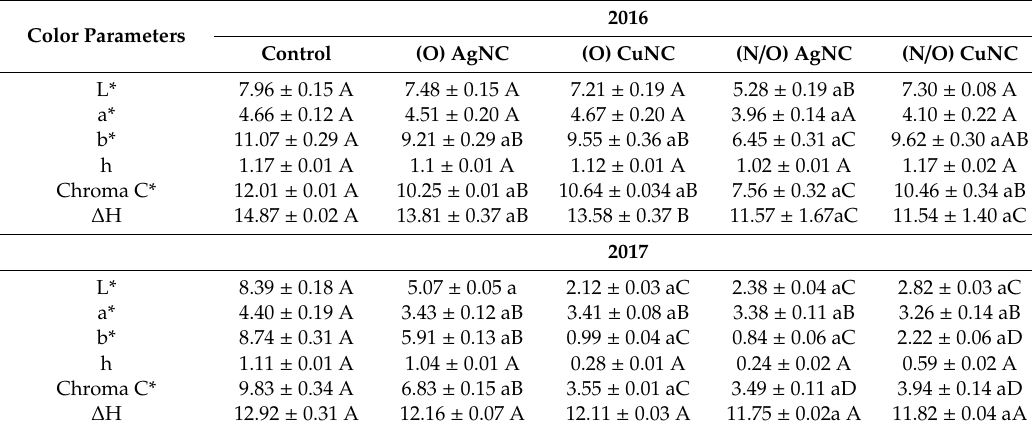
Table 2. Analysis of color parameters of virgin rapeseed